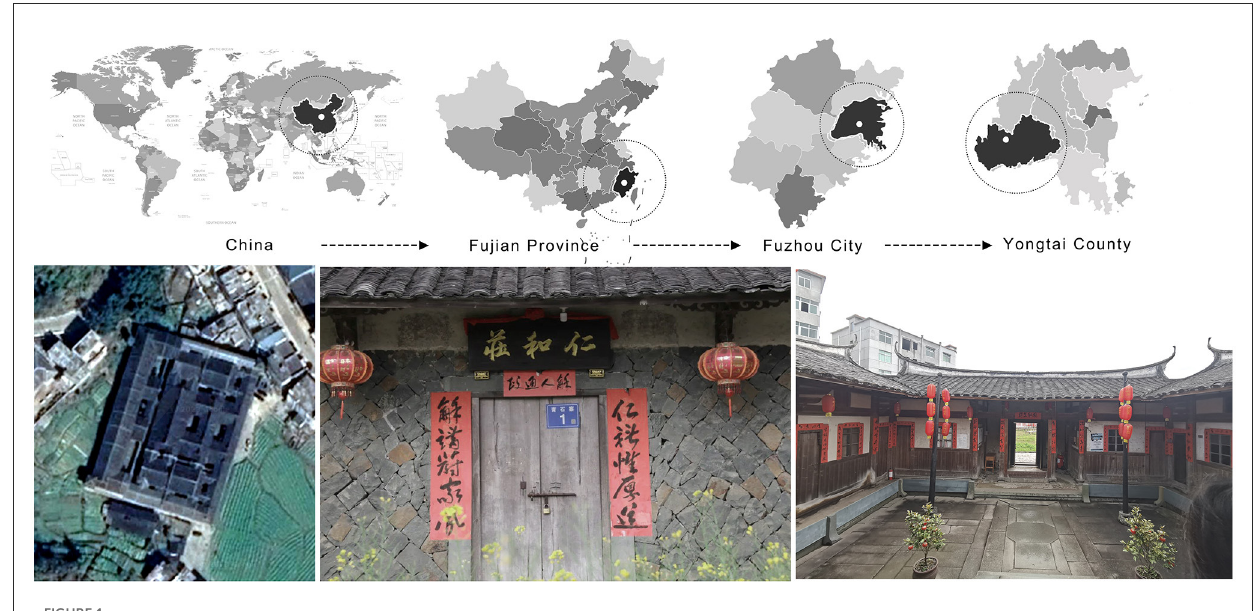
FIGURE1 Particulars of Renhe